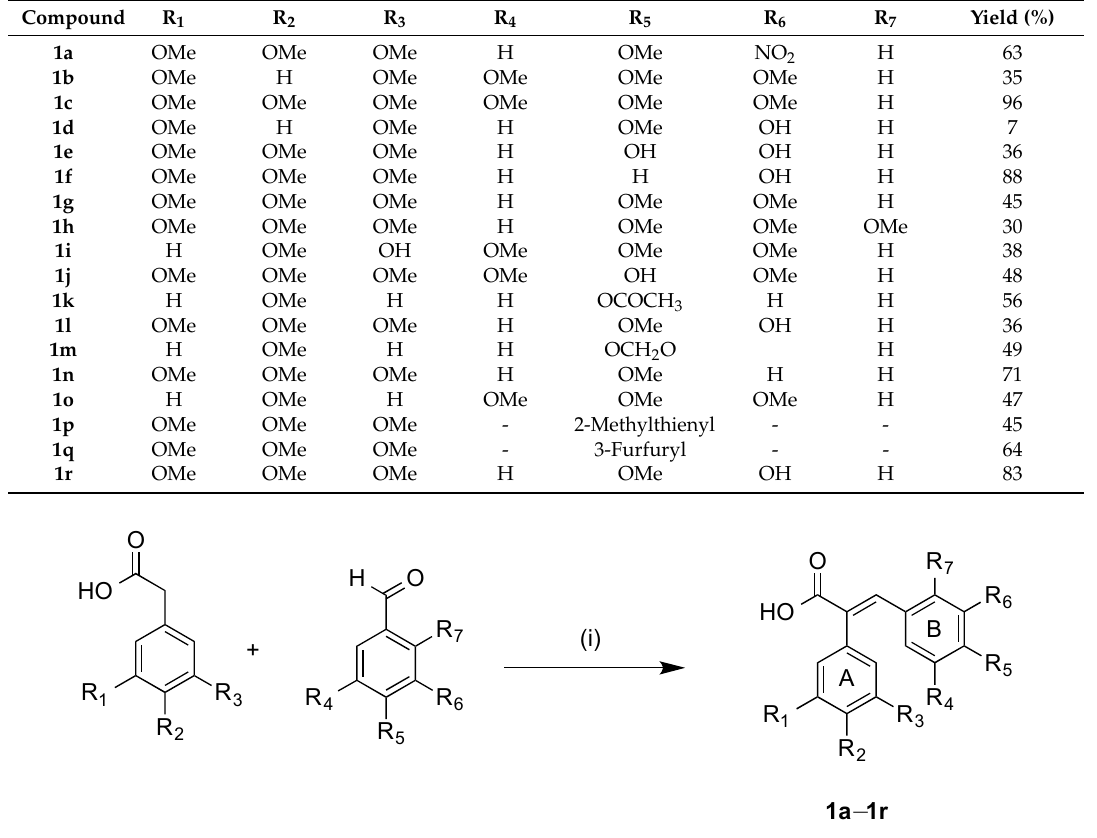
Table 1. Structures of acrylic acids 1a – 1r (see Scheme 1).